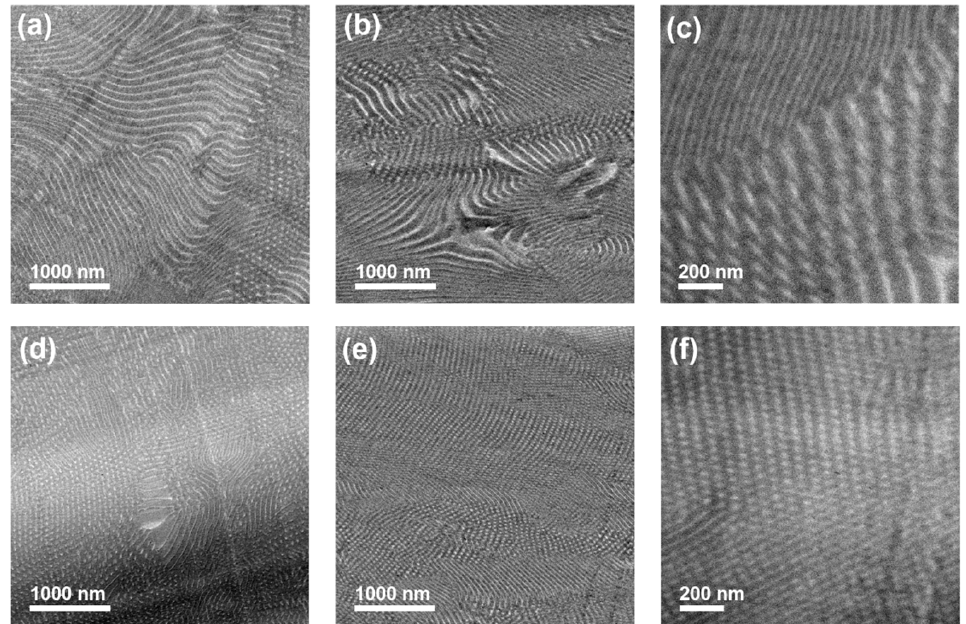
Figure 6. TEM images of the P(DMA- co -NIPAM)- b -PS bulk films. ( b , c , e , f ) The PS phase was selectively stained in RuO 4 vapor to increase the contrast. The PS phase appears dark and the P(DMA- co -NIPAM) phase bright. ( a ) P(DMA 29 -NIPAM 180 )-PS 937121 unstained bulk film; ( b , c ) P(DMA 29 -NIPAM 180 )-PS 937121 stained bulk film; ( d ) P(DMA 29 -NIPAM 180 )-PS 944122 unstained bulk film; ( e , f ) P(DMA 29 -NIPAM 180 )-PS 944122 stained bulk film.